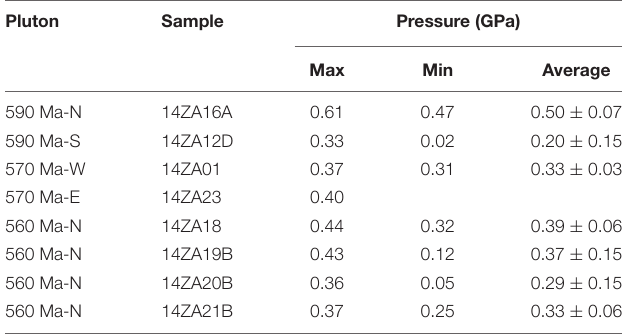
TABLE 3 | The range of biotite pressure estimates of the Gueìra Massif and Lake Fitri granites. Pluton